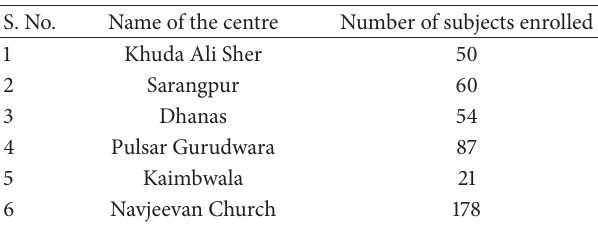
Table 1: Enrolment of subjects at different centres (Chandigarh,